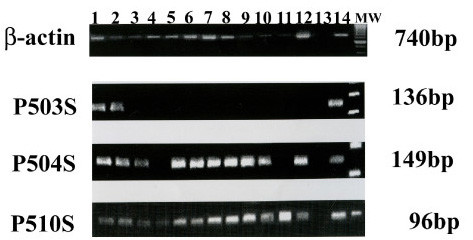
Analysis of gene expression levels of p503S, p504S and p510S by RT-PCR using β-actin yielded a 740 base-pair band as internal control, in whole blood from 11 patients with CaP after biopsy (lanes 1 to 11) and one patient with transitional cell carcinoma of the bladder (lane 12) as control. Negative control (no RNA) (lane 13); positive control (LNCaP cell line) (lane 14); MW (molecular weight).